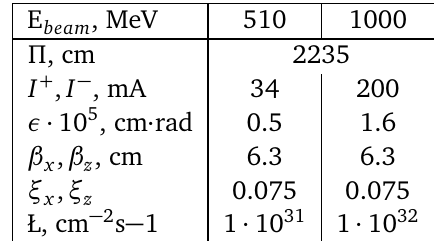
Table 1: Main project parameters of